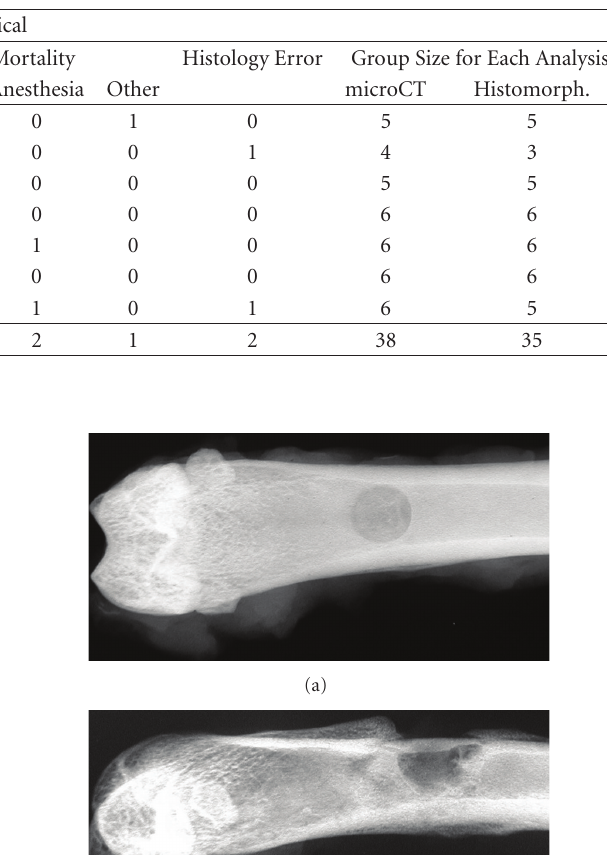
Table 1: Summary of Animal Disposition.